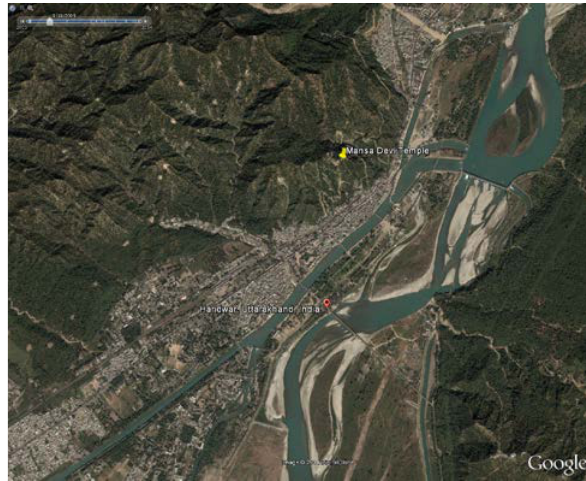
Figure 4: Overview over the town of Haridwar with the Mansa Devi temple northeast of the image centre (indicated by a yellow pin marker). Background data: GoogleEarth, imagery from 19 th September